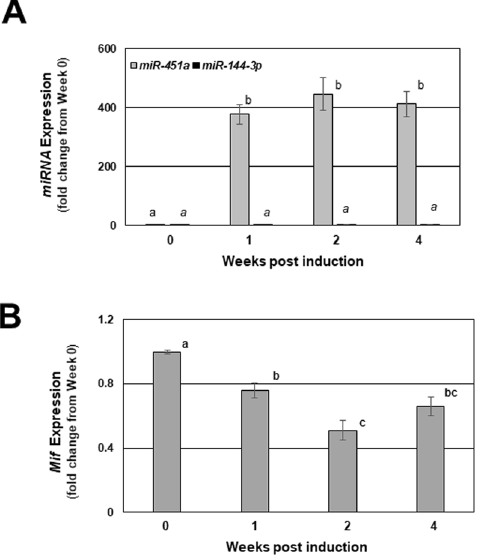
Figure 7. Mature miR-144-3p , miR-451a , and Mif transcript expression in endometriotic-like lesions from mice with experimentally induced endometriosis. Endometriosis was induced in wild-type mice using donor tissue from miR-144 - 3p / miR-451a null mice as described under “Materials and Methods” and mice were sacrificed at 1, 2 and 4 weeks post-induction (week 0 = time of induction). Endometriotic lesion-like structures were removed from each mouse, carefully minimizing underlying peritoneum contamination and total RNA was isolated. Murine miR-144-3p and miR-451a ( A ) were evaluated by qRT-PCR. miR-451a confirmed target transcript Mif was also evaluated by qRT-PCR in the same lesion tissues at each of the time points ( B ). Data are displayed as the mean ± SEM. Different letters indicate statistically significant differences among the means as determined by one-way ANOVA followed by post-hoc analysis (N = 6 per group; P < 0.05). Time 0 represents assessments made on tissue fragments (eventual lesions) that were harvested from donors but not transferred to recipient mice and served as the baseline for expression of the indicated miRNAs and their indicated